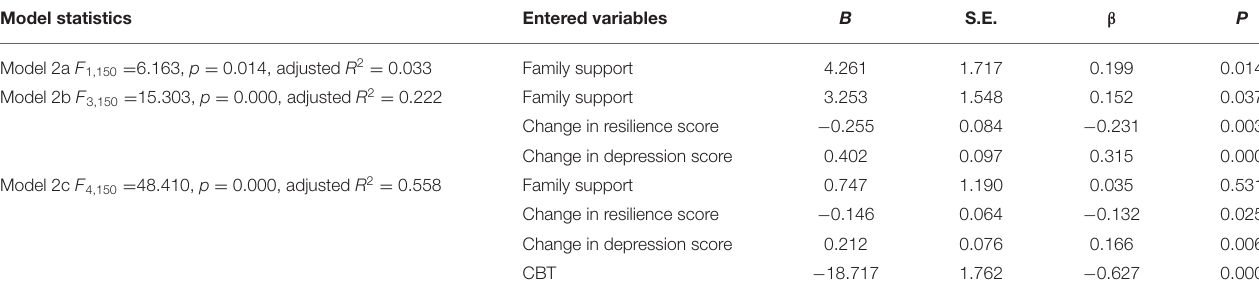
TABLE 3 | Predictors of changes in PTSD severity from study entry to follow-up. Model statistics Entered variables